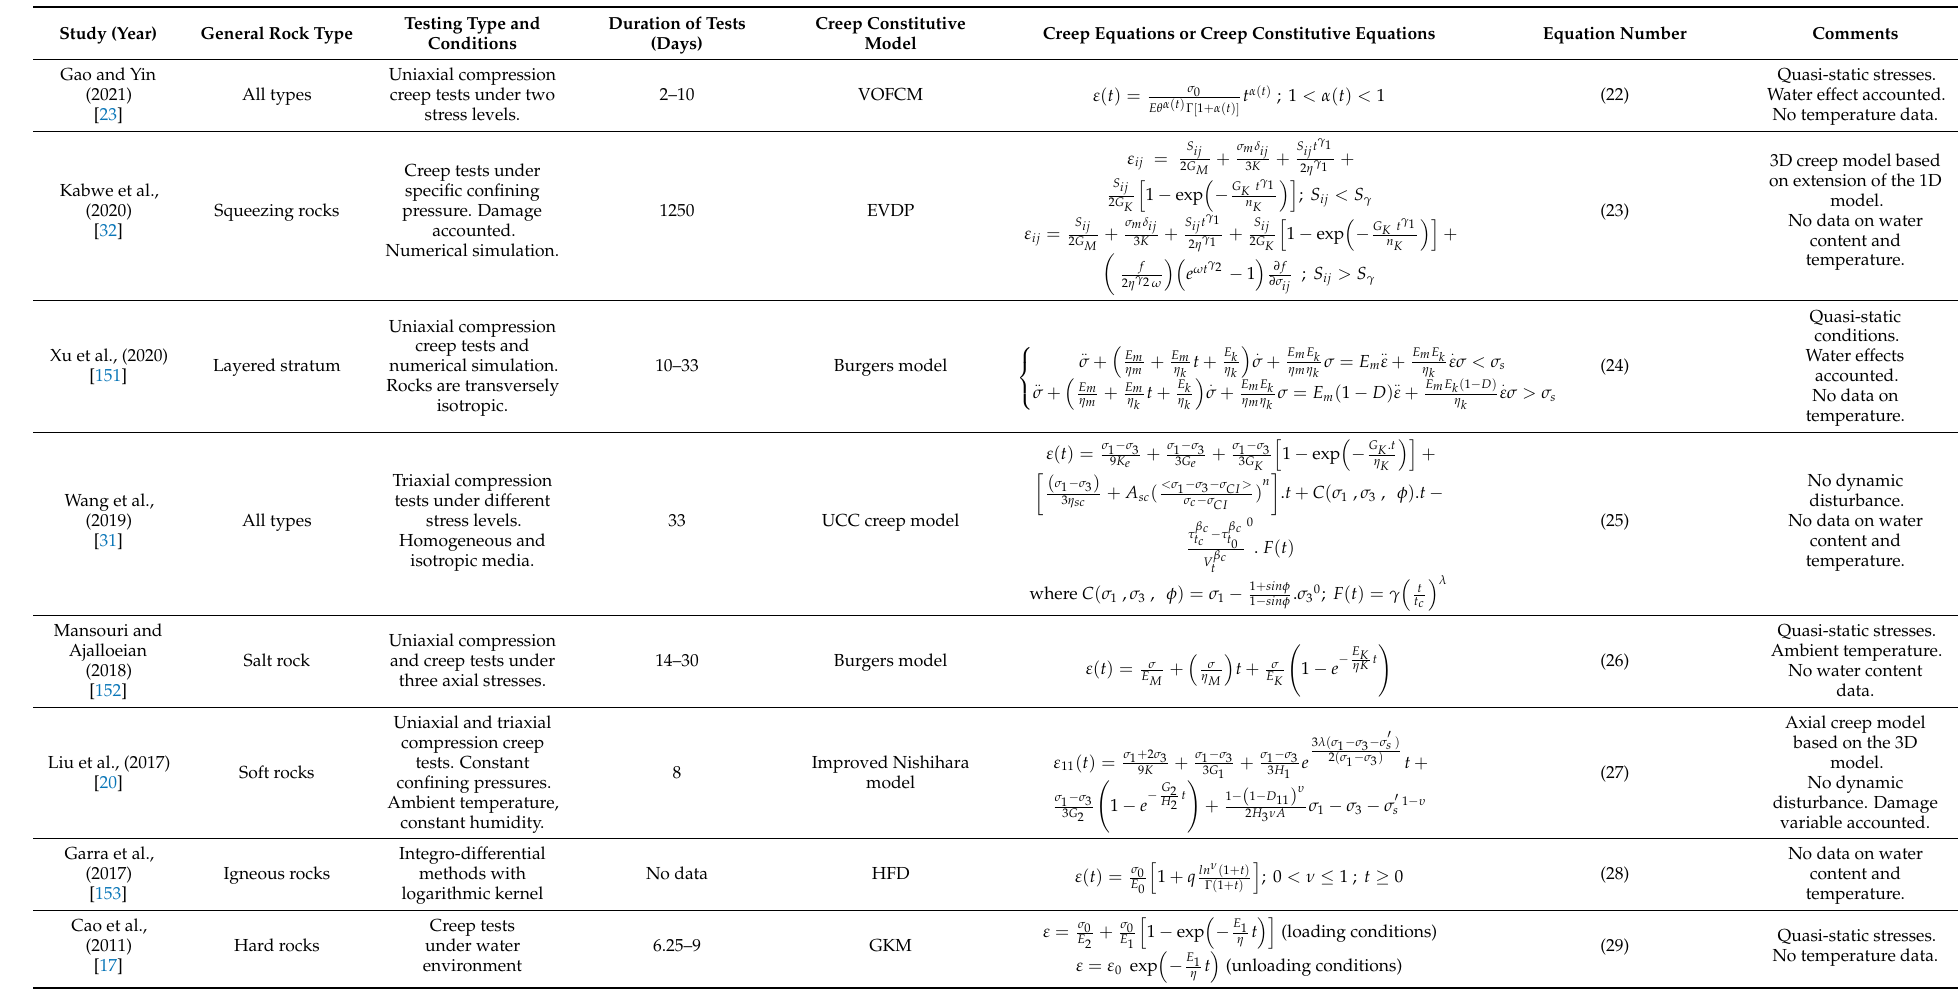
Table 5. Summary of relevant details of creep constitutive models for various general rock